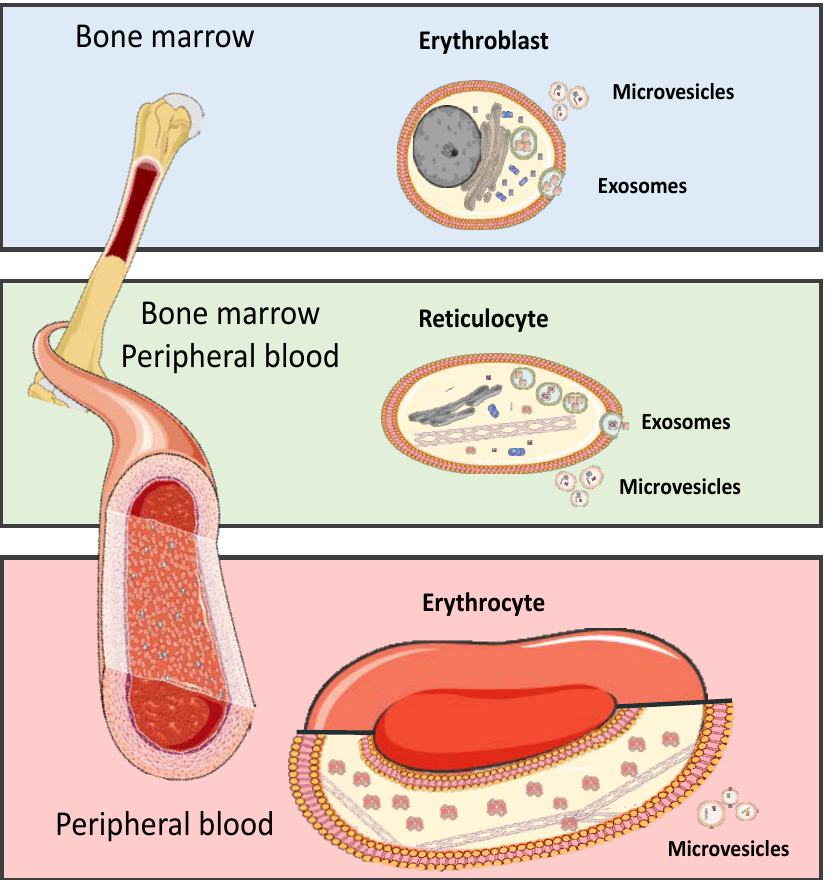
Figure 2. Source of red blood cells. Most blood cells develop from bone marrow cells—the spongy material in the center of the bones—and transfer into the circulation and further release exosomes and microvesicles .